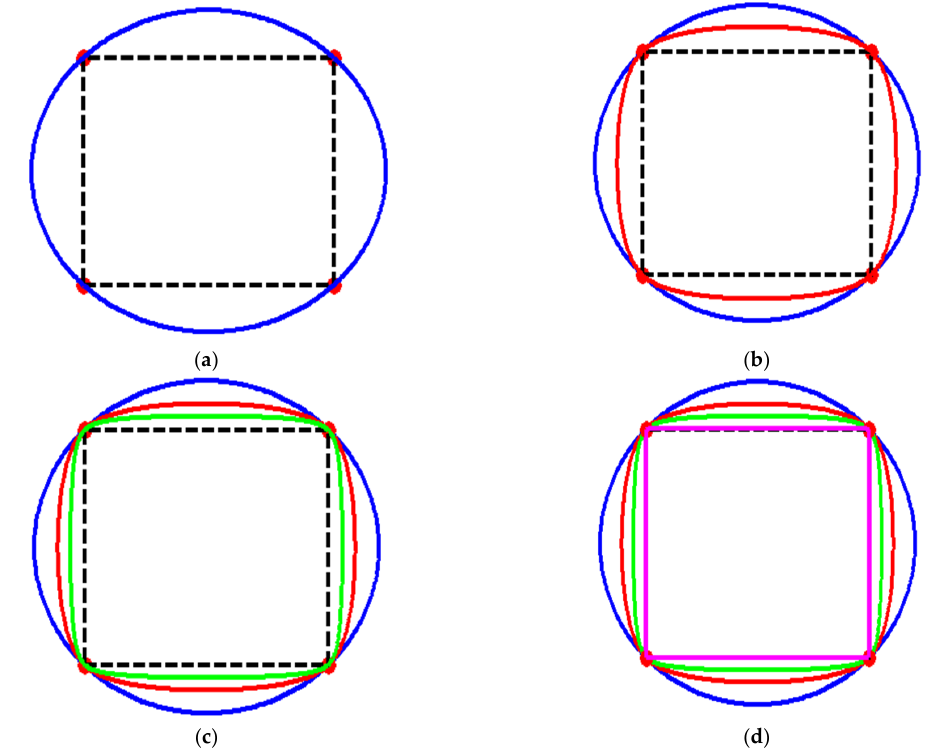
Figure 8. ( a – d ) are RQTS curve through global tension, by ρ i = σ i = 2, 3, 5, and 100 ∀ i .